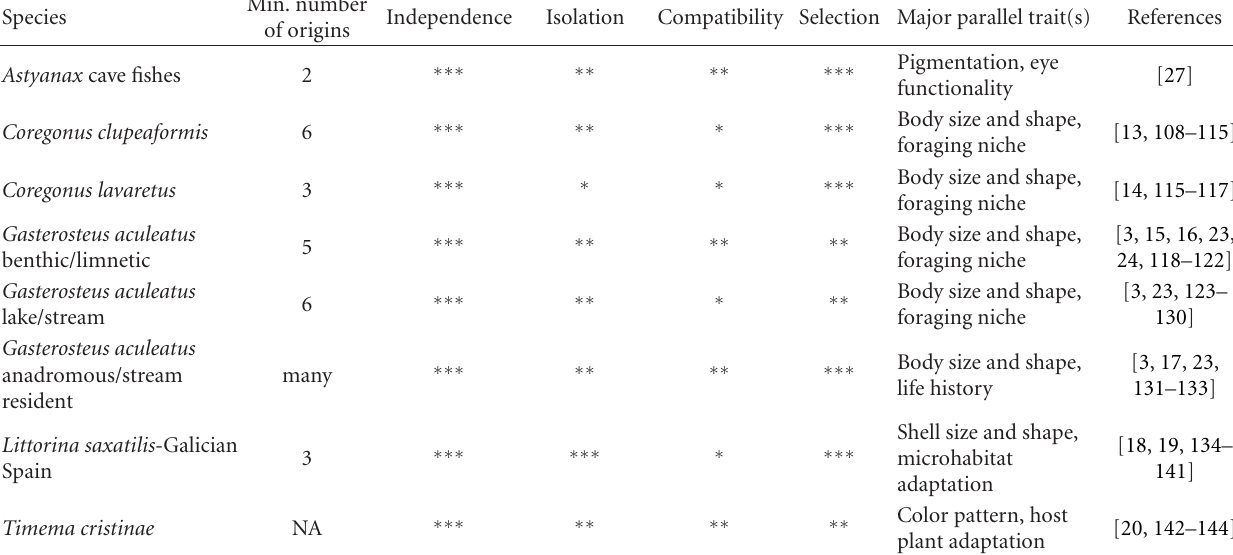
Table 2: Examples of parallel ecological speciation in animals showing the strength of evidence for each case. This list is not exhaustive and instead is a selection of well-studied cases serving as a comparison to the plant examples. The strength of evidence for each case was coded as follows: ∗∗∗ : strong direct evidence, ∗∗ : weak direct evidence, ∗ : indirect evidence, —: no evidence, † : evidence against, and NA: no data.